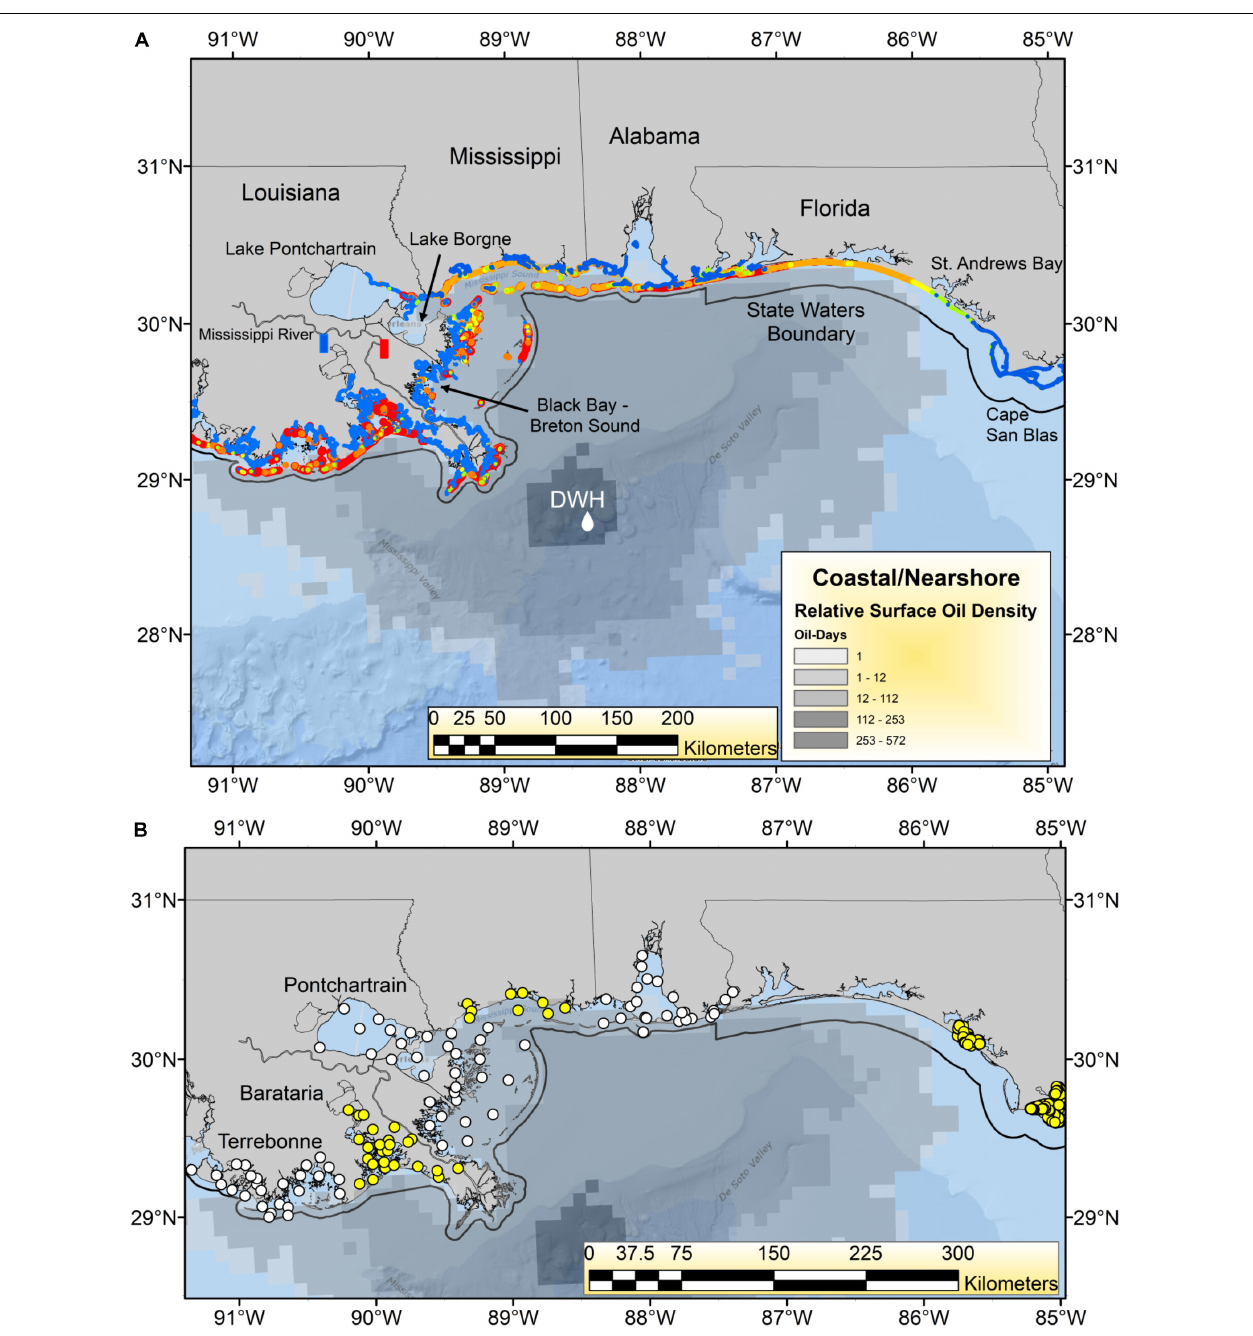
FIGURE 1 | (A) Geographic footprint of surface oil expression [number of “oil days” i.e., days oil was present at each pixel of the oil surface multiplied by the relative oil thickness (Murawski et al., 2014)] and shoreline oiling relative concentrations for the Deepwater Horizon (DWH) oil spill in 2010. Shoreline oiling colors indicate maximum levels observed from the National Oceanic and Atmospheric Administration’s SCAT (Shoreline Cleanup Assessment Technique) results: (https://catalog.data.gov/dataset/deepwater-horizon-mc252-response-data-from-the-environmental-resource-management-application-er9c019). Color codings are: blue = no oiling, yellow = light, orange = medium, red = heavy oiling. The boundaries of state territorial waters are plotted as a black line. The Mississippi River diversions at Davis Pond (blue rectangle) and Caernarvon (red rectangle) are identified. (B) Locations of most recent trawl survey stations for each state and region. Alternating yellow and white circles indicate identity of adjacent regions or states. Three estuarine systems in coastal Louisiana (Pontchartrain, Barataria, and Terrebonne) are identified.